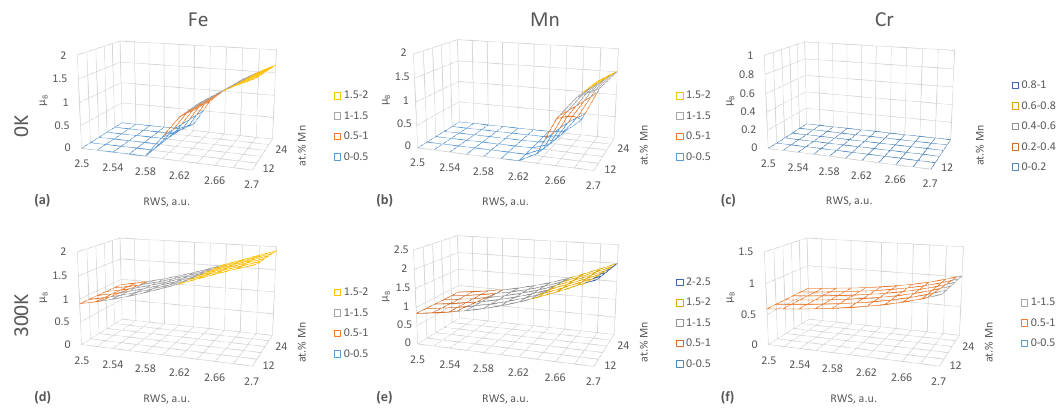
Figure 3. Magnetic moments (in µ B ) in FeCr 10 Mn 12–32 PM alloys as a function of Wigner-Seiz radii and Mn concentration. ( a ) Magnetic moments on Fe atoms at 0 K. ( b ) Magnetic moments on Mn atoms at 0 K. ( c ) Magnetic moments on Cr atoms at 0 K. ( d ) Magnetic moments on Fe atoms at 300 K. ( e ) Magnetic moments on Mn atoms at 300 K. ( f ) Magnetic moments on Cr atoms at 300 K.